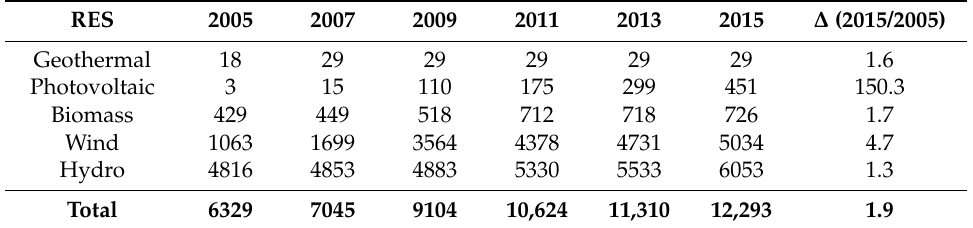
Table 5. Renewable energy sources’ installed capacity (MW) in Portugal for electricity production and corresponding variation in the 2005–2015 decade